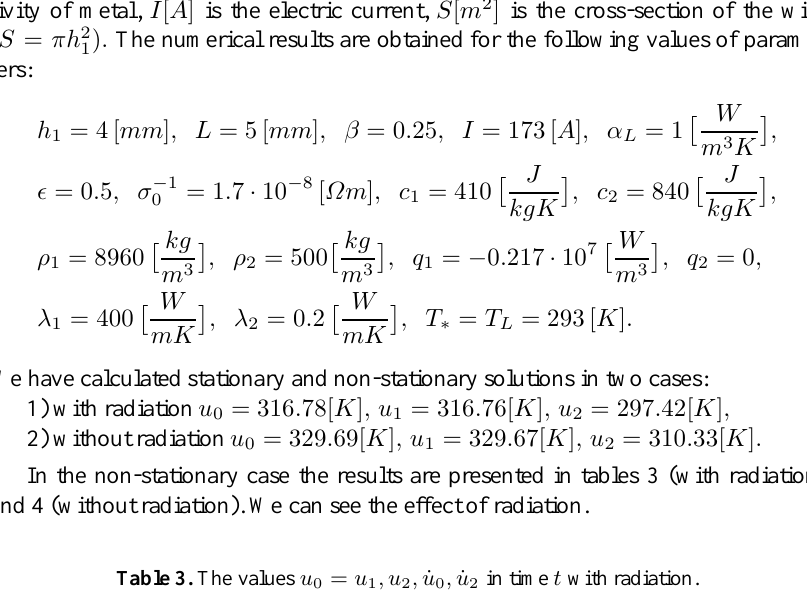
Table 3. The values u 0 = u 1 ; u 2 ; _ u 0 ; _ u 2 in time t with radiation.